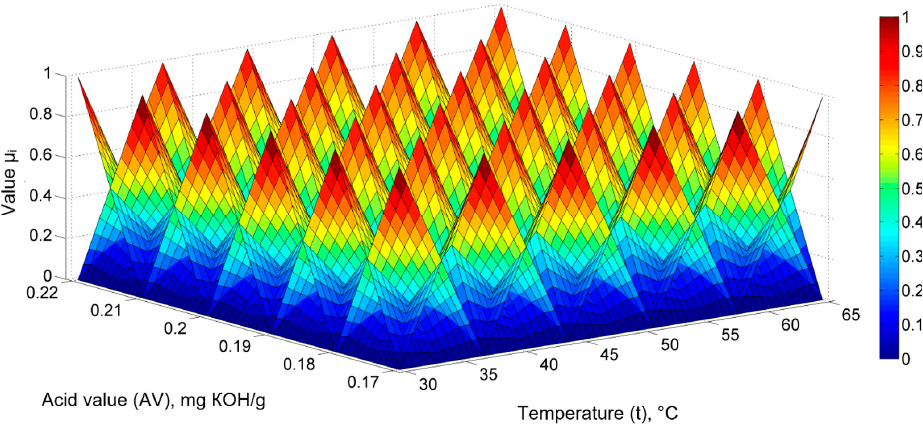
Figure 2. Generalized fuzzy mathematical model PV = f (t, AV) for sunflower oil, sea buckthorn, and rose hip extracts: triangular fuzzy set representation (6 and 6).